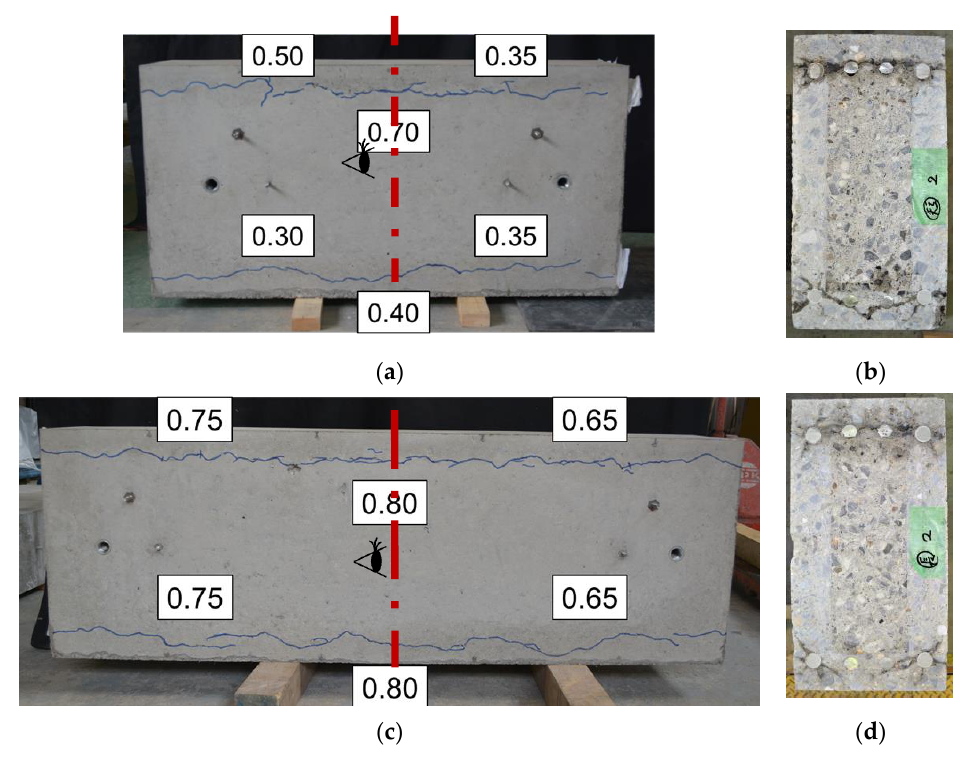
Figure 4. Crack simulated on beam with EAFP: ( a ) longitudinal surface crack in short specimen; ( b ) Internal crack in short specimen; ( c ) longitudinal surface crack in long specimen; ( d ) internal crack in long specimen.